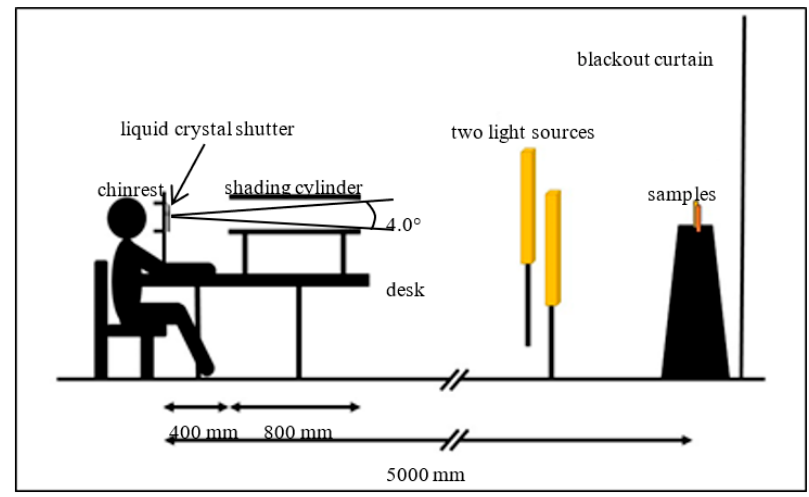
Figure 1. Research environment. Two evaluation samples are placed 5 m away from the participants.